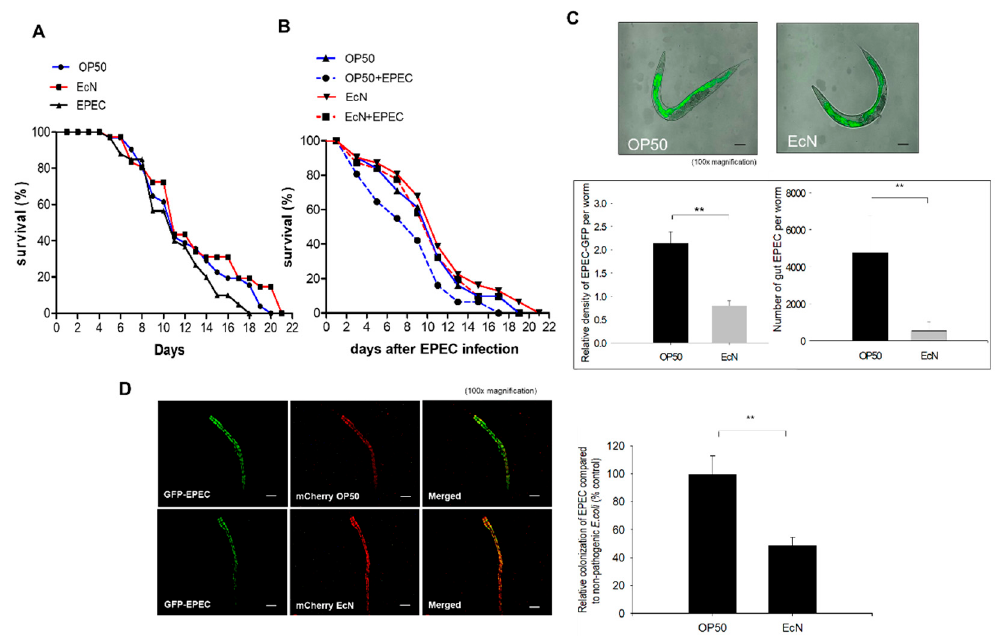
Figure 1. Effect of Escherichia coli strain Nissle 1917 (EcN) on enteropathogenic E. coli (EPEC)-infected worms. ( A ) For lifespan assays in the presence of each bacterium, presynchronized L4 worms were grown on the E. coli OP50, EcN, and EPEC lawns (without tryptophan) for 48 h. To prevent the progeny of the produced offspring, worms were transferred to a new nematode growth medium (NGM) plate every day. The survival of the worms was assessed by counting living worms daily. ( B ) For lifespan assays to measure the impact of EcN pretreatment, presynchronized L4 worms were grown on E. coli OP50 or EcN lawn for 48 h and were further grown on NGM plates containing OP50 or EPEC in tryptophan (2 mg/mL) for 48 h. The survival of the worms was assessed by counting living worms daily after EPEC infection (day = 1). ( C ) Fluorescence microscopic observation was used to visualize the amount of EPEC (the upper panel, original magnification ×100; scale bar(s), 100 μ m). The experiments were performed as follows. Wild-type (N2) worms were exposed to GFP-expressing EPEC for 48 h on NGM plates containing tryptophan (2 mg/mL) after being fed E. coli OP50 and EcN for 48 h. The lower graphs indicate the quantitative analysis of EPEC in the gut. Asterisks represent significant differences between the groups (** p < 0.01). All data represent three independent experiments. ( D ) Competitive bacterial colonization in the worm gut. Worms were preincubated with mCherry-labeled nonpathogenic E. coli (OP50 or EcN, red) for 24 h before being infected with GFP-labeled EPEC (without tryptophan, green color) for 24 h. The right panel shows the quantification of GFP-labeled EPEC in the gut. The results are shown as mean values ± SEM (Standard error of the mean) ( n = 18), with the asterisk representing significant difference from the OP50-exposed control group (** p < 0.01). Each result is representative of three independent experiments.